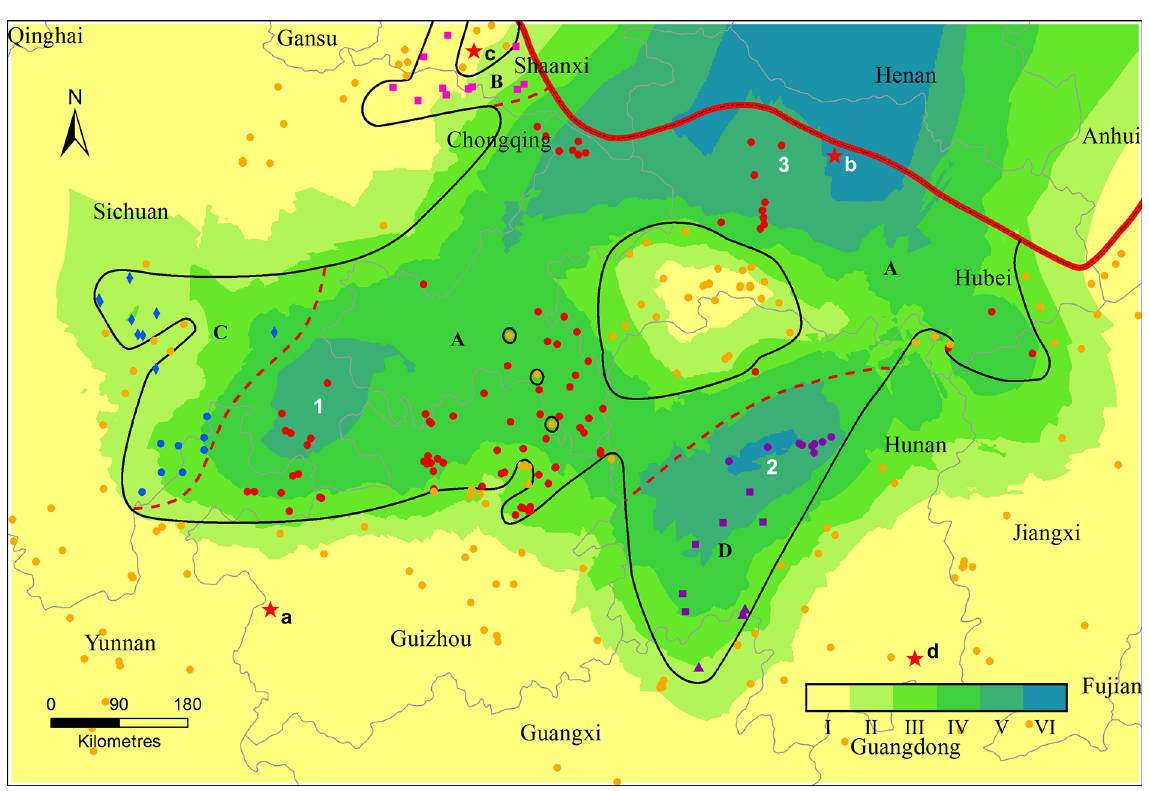
Fig. 2. Reconstructed palaeotopography of the Upper Yangtze region in the Hirnantian. Different colours indicate different ranks of water depths. The red solid line indicates the northern boundary of the South China Palaeoplate; black lines indicate the palaeo- coastlines and the outlines of the submarine highs; red dashed lines indicate the boundaries of different sedimentary facies. The dots are section locations: yellow dots indicate the localities without Hirnantian sediments; red dots indicate the localities deposited with the Kuanyinchiao Beds; ginger pink rectangles indicate the localities deposited with the Nanzheng Formation; blue diamonds indicate the localities deposited with the Daduhe Formation; blue dots indicate the localities deposited with the Tiezufeike Formation; purple rectangles indicate the localities deposited with the Tianmashan Formation; purple triangles indicate the localities deposited with the Tianlingkou Formation; purple dots indicate the localities deposited with black shales. Stars a, b, c and d represent the end points of the two transects in Fig. 4. The palaeo-coastlines and the outlines of the submarine highs are constrained by drawing lines to separate the sections with or without the Hirnantian sediments. The contour map was created by interpolating the water-depth ranks, which is likely affected by the quantity and distribution of the sections data. So, those lines and the boundaries in the contour map may not entirely fit each other in some regions with fewer